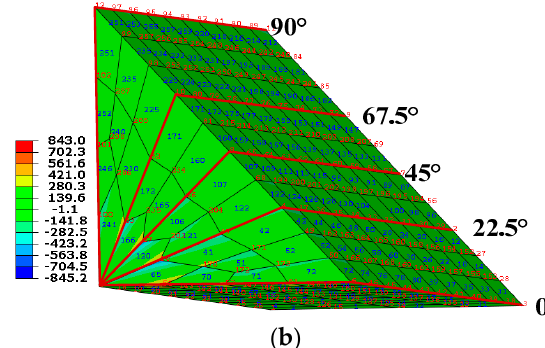
Figure 6. Nodal force of different sections: ( a ) transverse welded specimen; ( b ) longitudinal welded specimen.